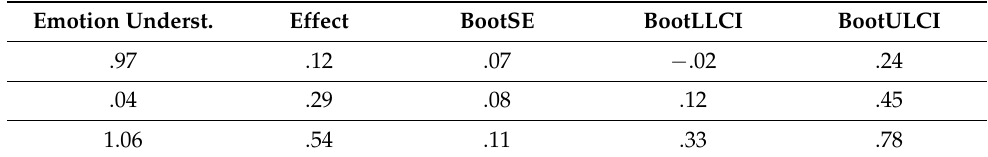
Table 3. Results of the moderated mediation for negative scenario and negative retrieval. Out- come variables are: ( a ) negative retrieval, ( b ) impression formation, ( c ) results of the conditional indirect effect. (a) Outcome: negative retrieval (R 2 = .5 8). Stand. coeff. se t p LLCI ULCI Negative scenario .60 .72 Emotion Underst. (EU) .24 .36 ScenarioXEU Mood_overall (b) Outcome: impression formation (R 2 = .5 8). Stand. coeff. se p LLCI ULCI Negative scenario .30 Negative retrieval .47 Emotion Underst. (EU) ScenarioXEU .17